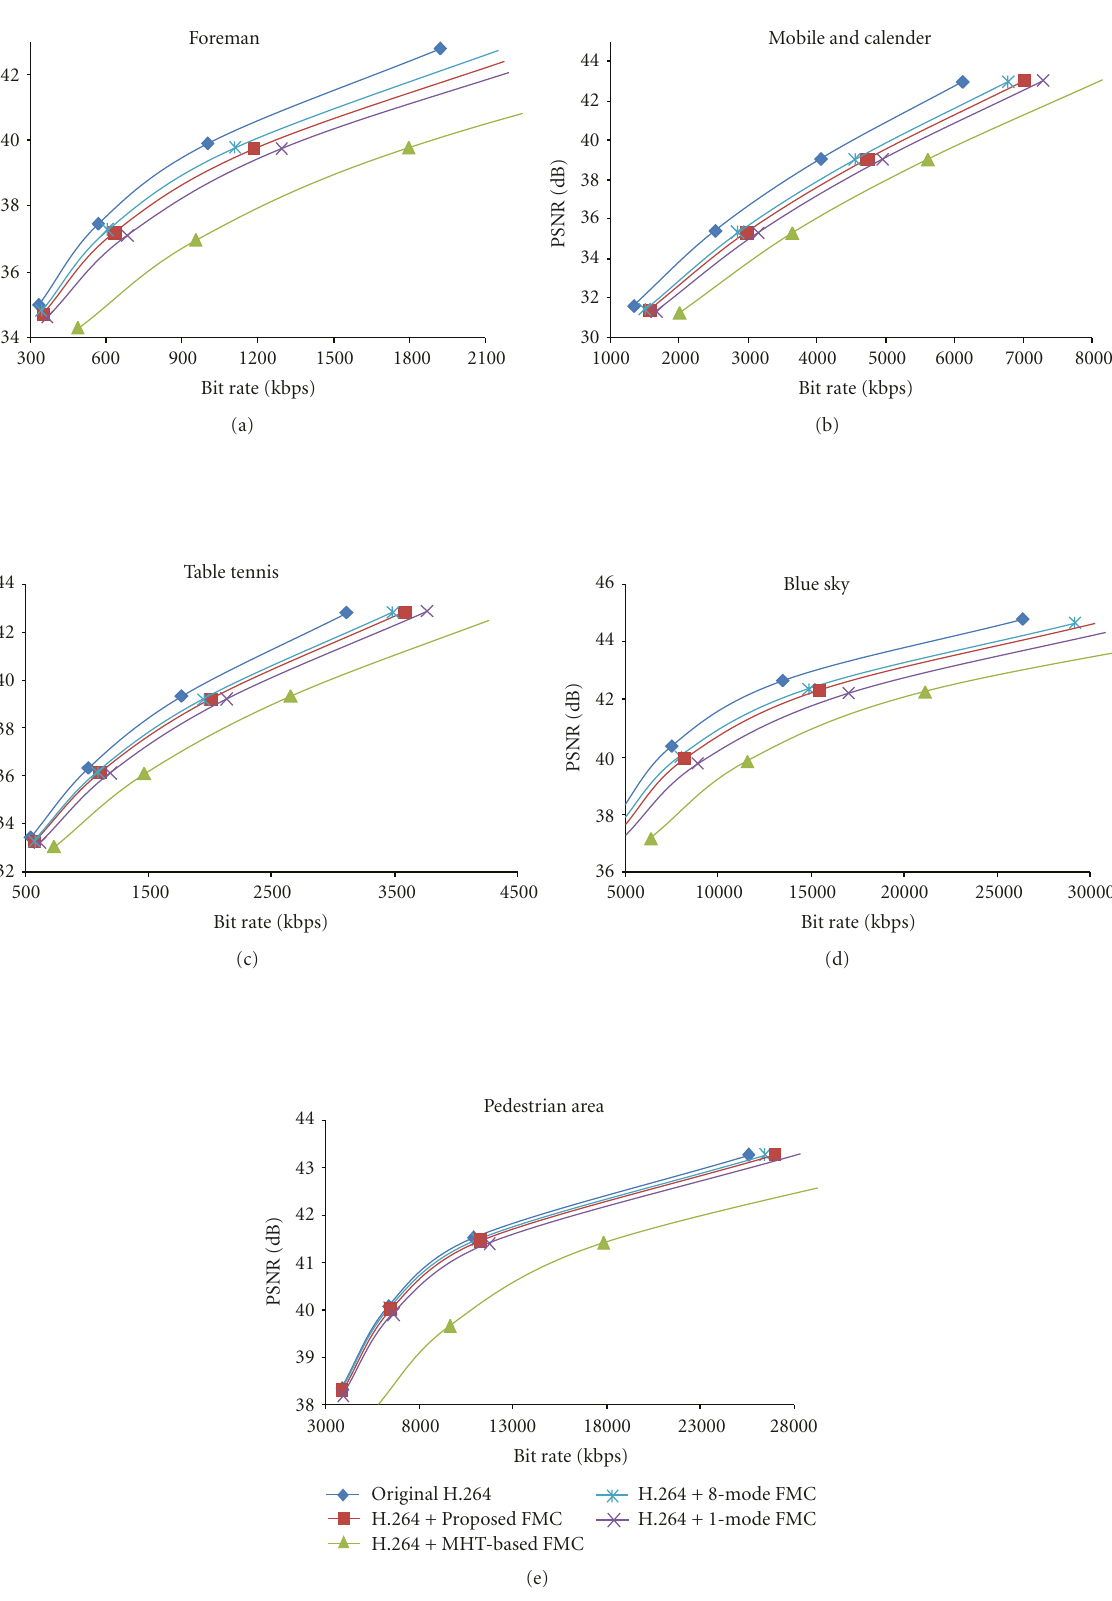
Figure 12: Rate distortion performance comparison of various FMC algorithms integrated into an H.264